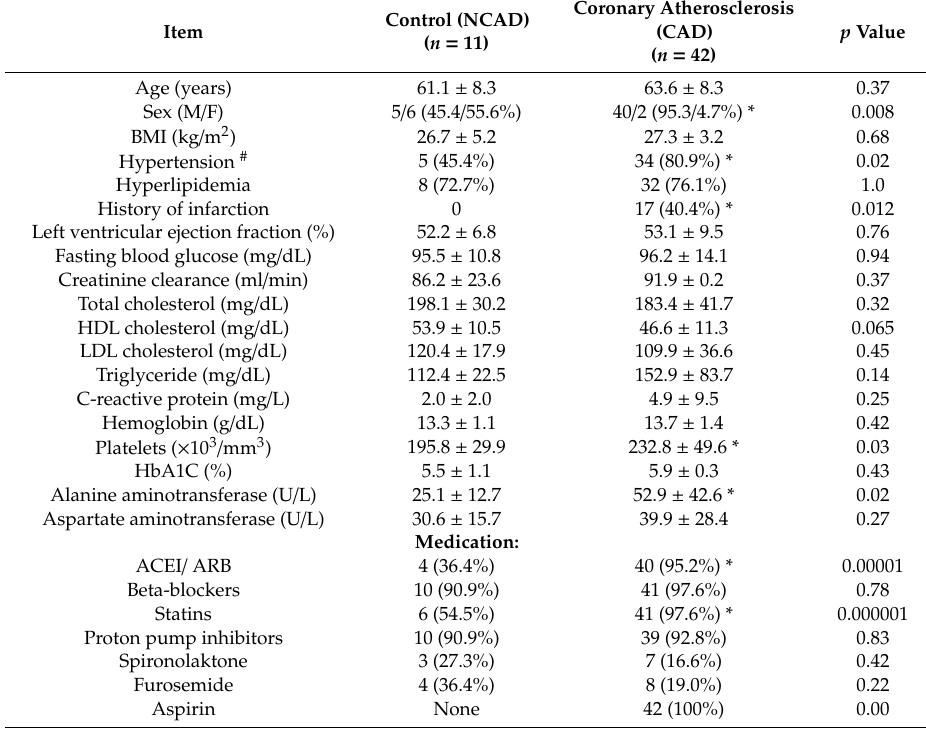
Table 1. Clinical characteristics of the subjects. Data are presented as mean ± SD.